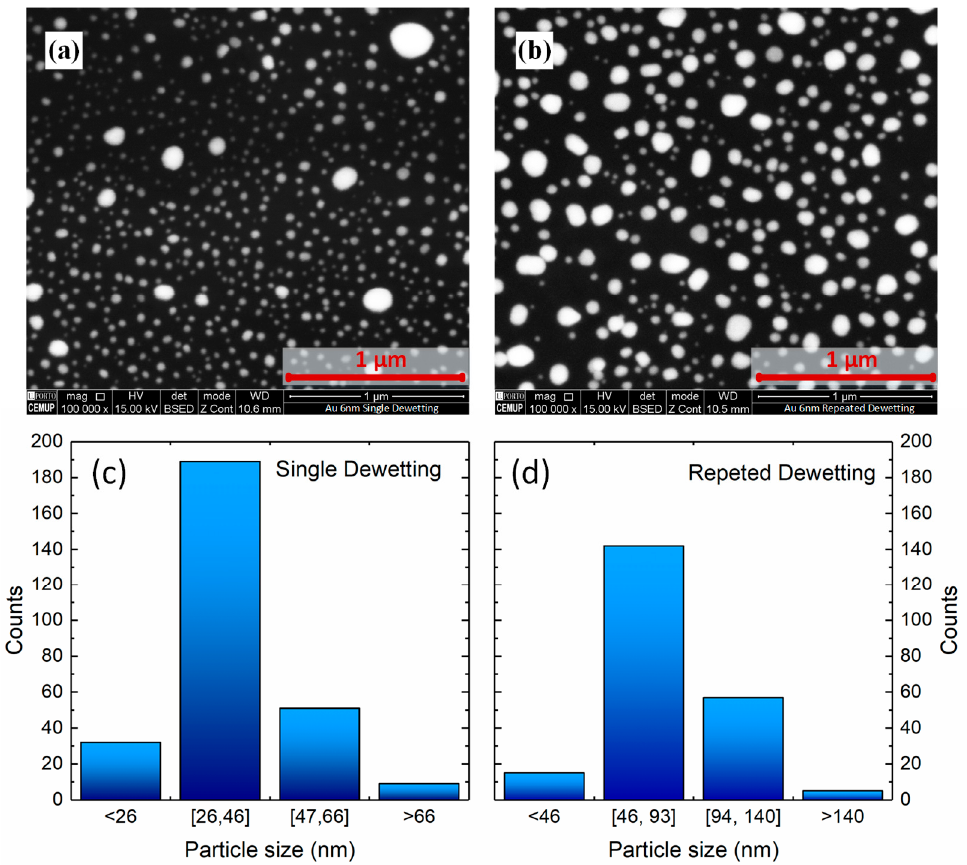
Figure 9. Scanning Electron Microscope photographs of gold nano-islands under different dewetting conditions of 6 nm thick gold film: ( a ) single step and ( b ) repeated dewetting. Plots ( c , d ), are calculated showing distribution of particle size, for samples shown in ( a , b ), respectively.